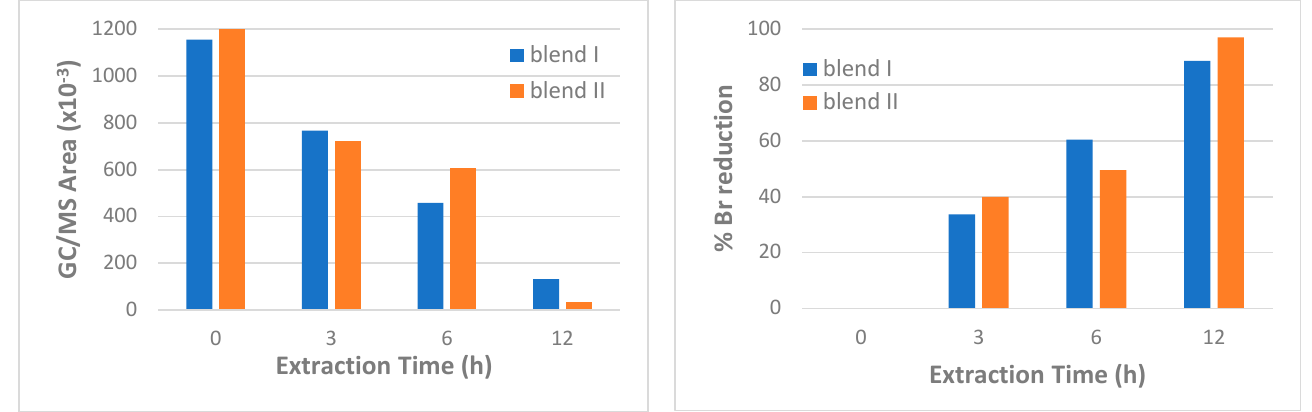
Figure 9. Effect of extraction time on GC/MS area of dibromophenol peak (left) and on percentage bromine reduction (right), for blend I and blend II.